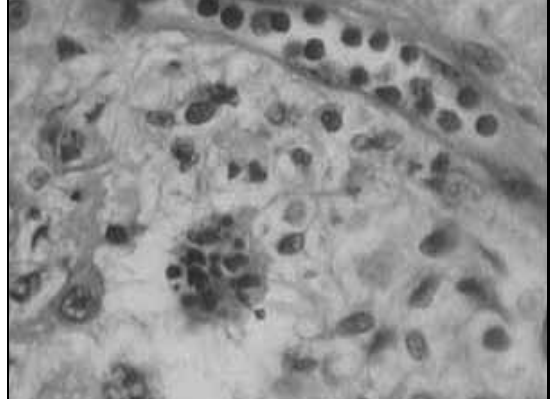
Figura 5 – Hematoxilina e eosina 400×: no centro da figura nota-se histiócito com células inflamatórias íntegras no citoplasma (emperipolese)